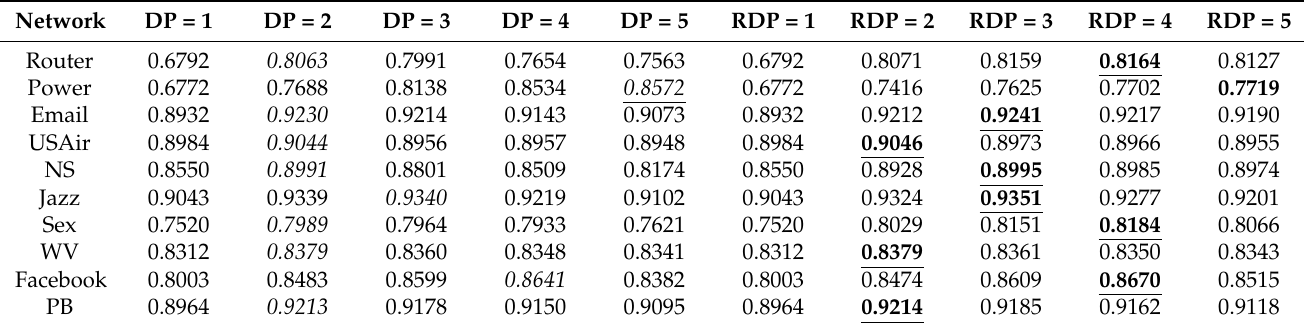
Table 5. The accuracies of DP and RDP with different iterations.